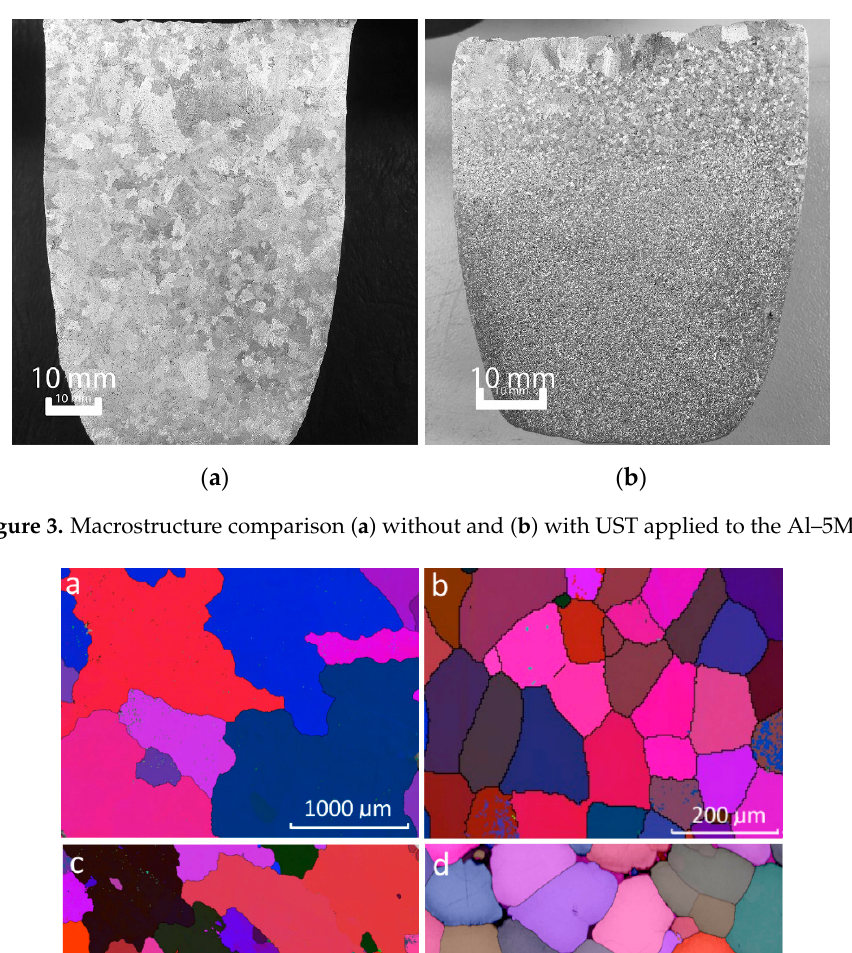
Figure 3. Macrostructure comparison ( a ) without and ( b ) with UST applied to the Al–5Mg